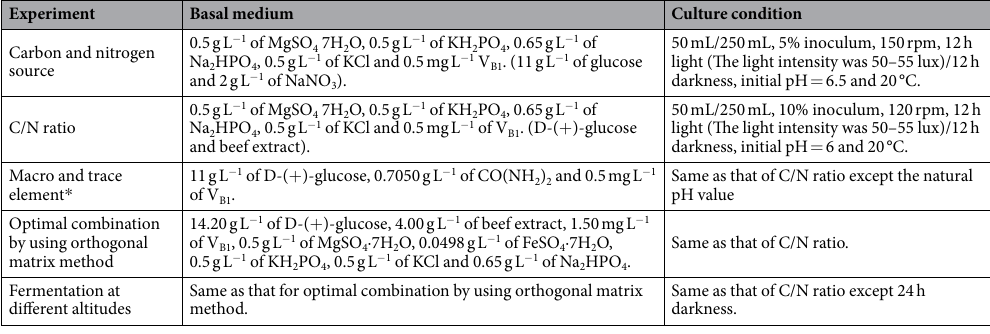
Table 14. Basal medium and culture conditions for the mycelial growth of Isaria farinosa during some experiments. * The basal medium excluding the test factor